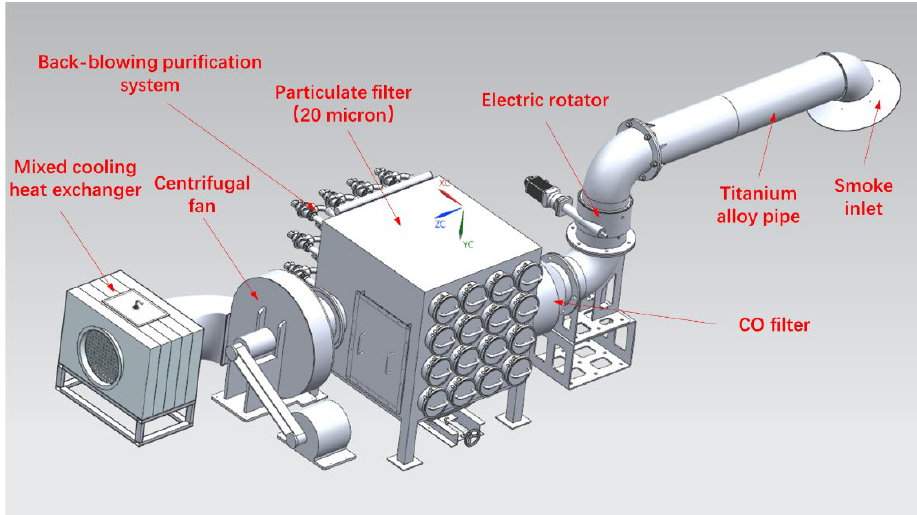
Figure 2. Design of the fire smoke decontamination system.